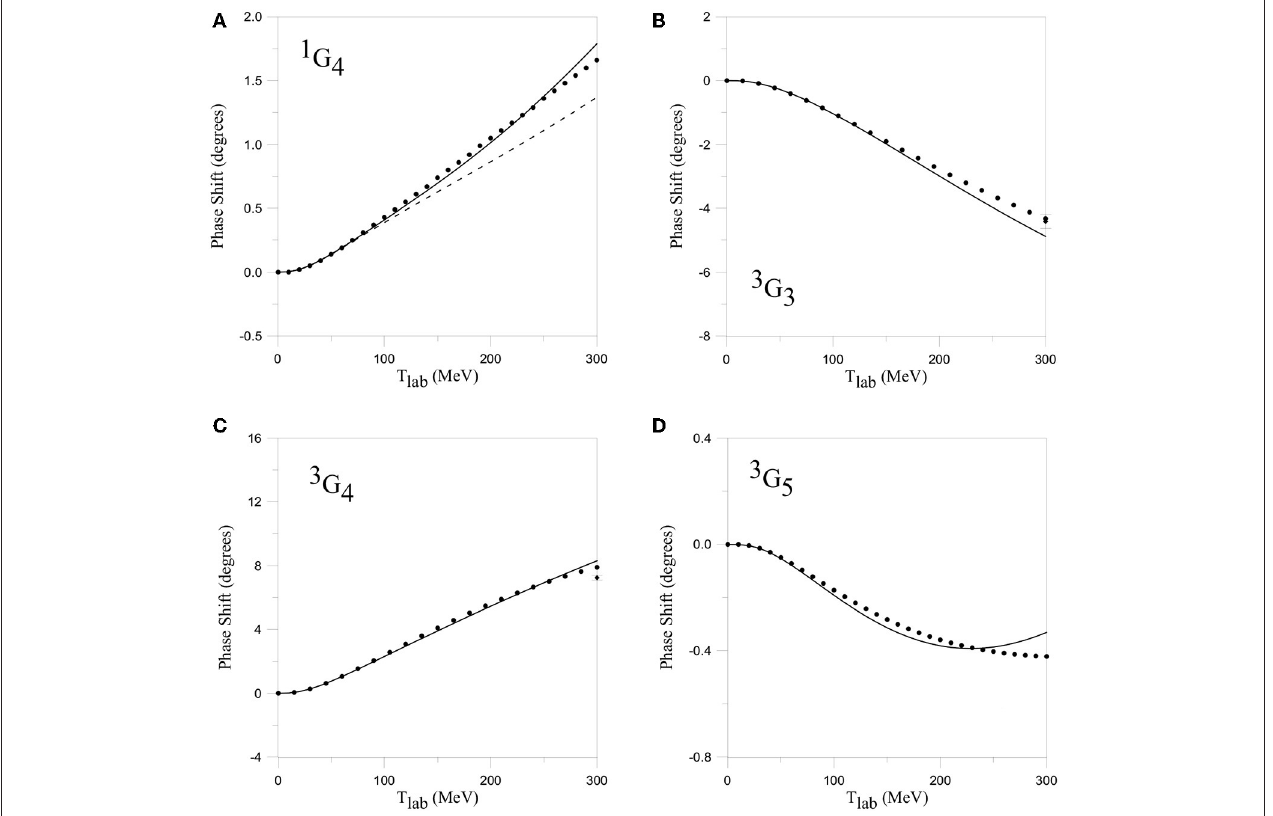
FIGURE 10 | NN G phase shifts in the T Entem et al. [ 52] Copyright (2000) by the American Physical Society.